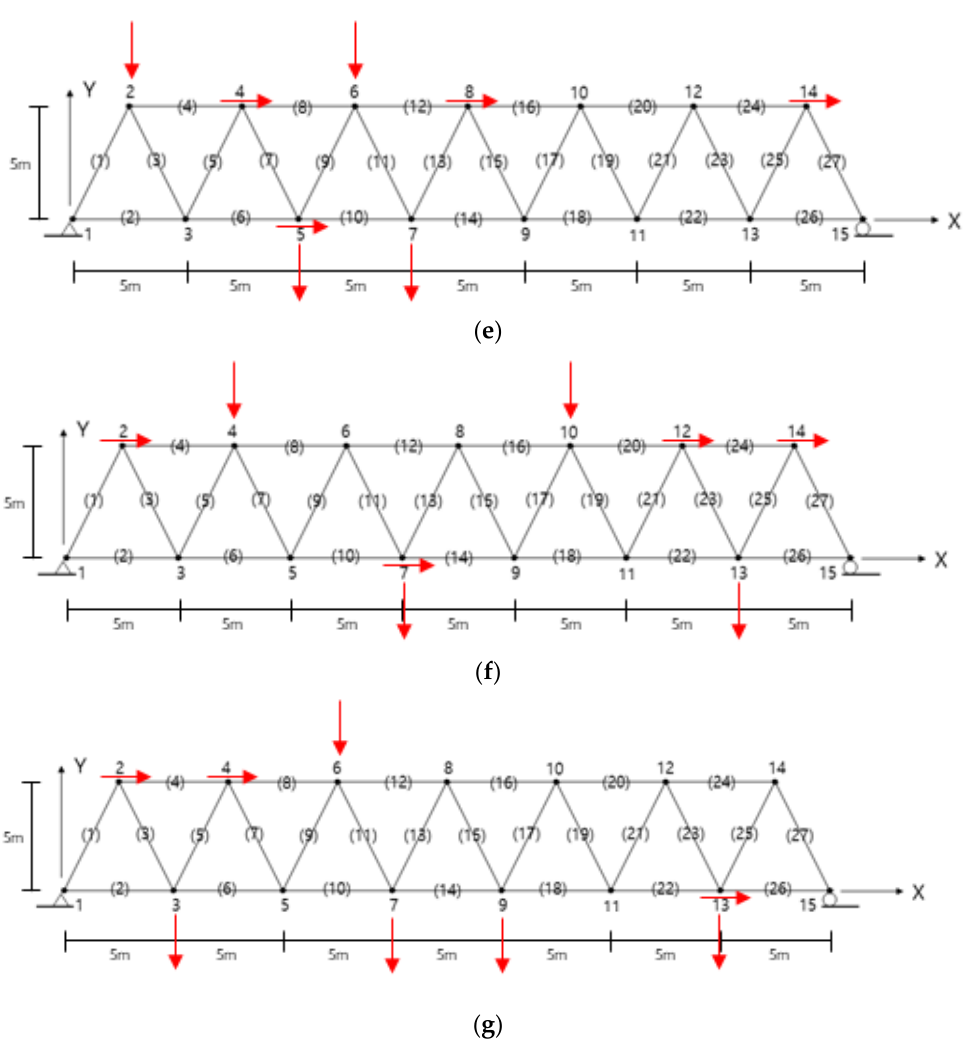
Figure 2. OSPs obtained from the proposed methods: ( a ) MR–EI, ( b ) CDE–EI, ( c ) MMKE27, ( d ) MMKE11, ( e ) MMSE, ( f ) MMAC, ( g ) Hao. The number without parentheses indicates the node and the number with parentheses the element.